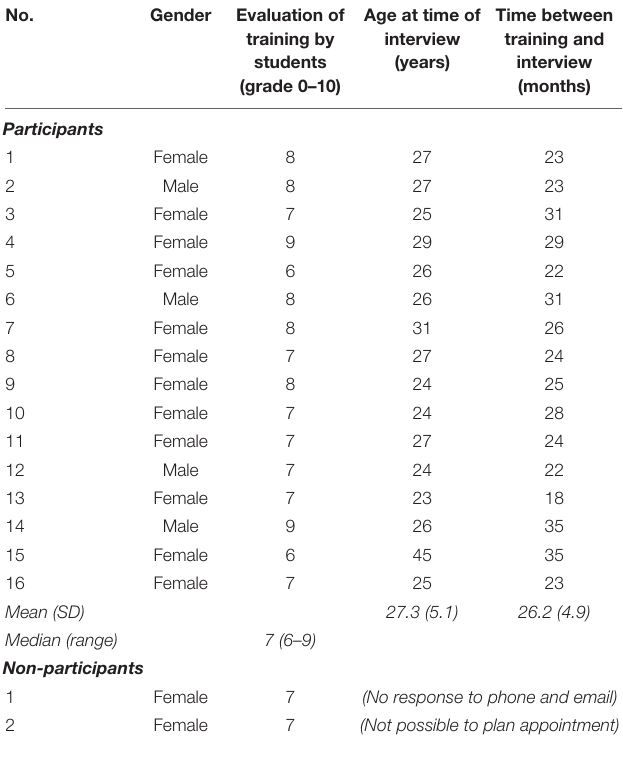
TABLE 1 | Characteristics of interviewed clerkship students and non-participants from Radboudumc, Nijmegen, Netherlands (2013–2014), 2 years after participation in mindfulness-based stress reduction